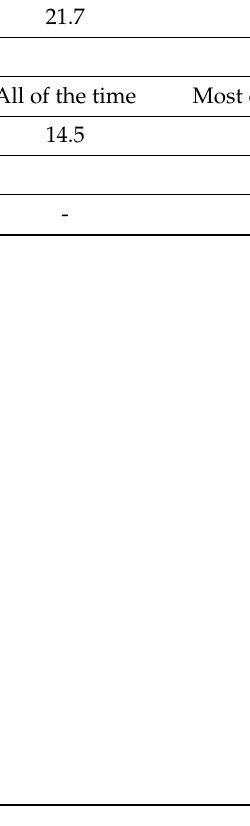
Table 1. Percentage of response frequencies (%) relating to items #1, #9 and #11 of the SF-12. SF-12 Item #1 “In general, would you say your health is”